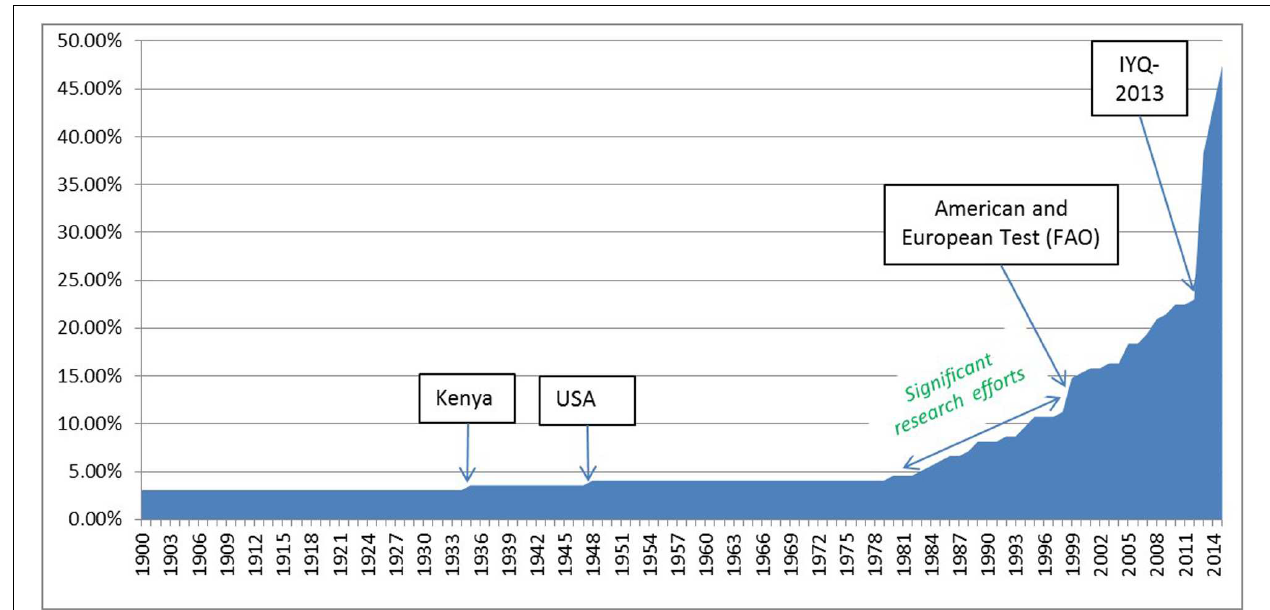
FIGURE 1 | Percentage of UN countries with quinoa experimentation or cultivation